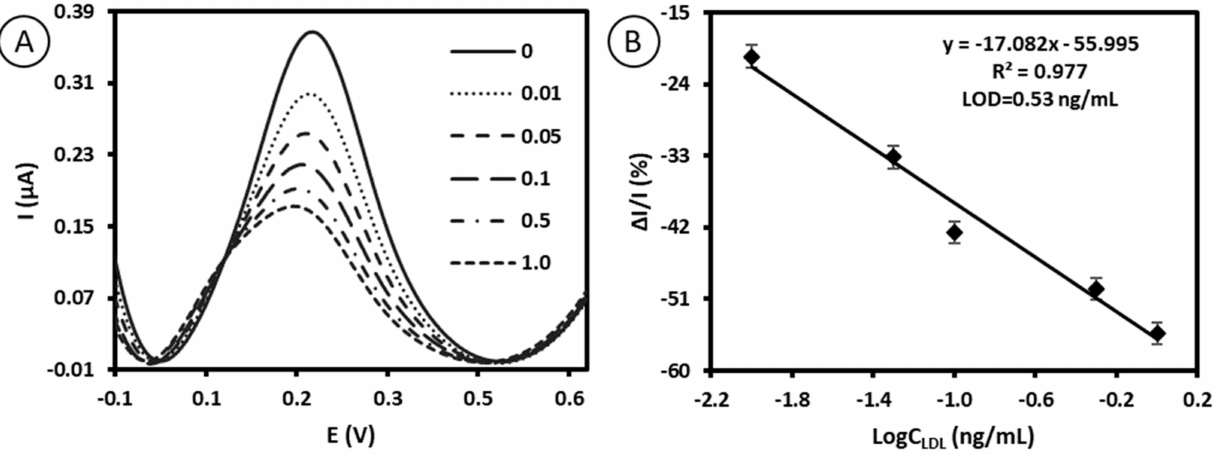
Figure 4. ( A ) Square wave voltammograms recorded for immunosensor upon contact with LDL standard solution with different concentrations (0, 0.01, 0.05, 0.1, 0.5, 1.0 ng/mL). The measuring parameters of SWV: step potential = 5 mV; square wave frequency = 10 Hz; amplitude = 50 mV. ( B ) The relationship between relative intensity of ferrocene redox current vs. log concentration of LDL ( ∆ I = I n – I, where I n is the peak current value registered at particular “n” concentrations of LDL and I is the peak current value measured in buffer free of LDL (n = 5)). Measuring conditions: 0.1 M Table 1. Comparison of various reported immunosensors for the detection of LDL with the im- munosensor proposed in this work based on antibody–ferrocene conjugates. Substrate Redox Electrochemical Method Limit of Detection